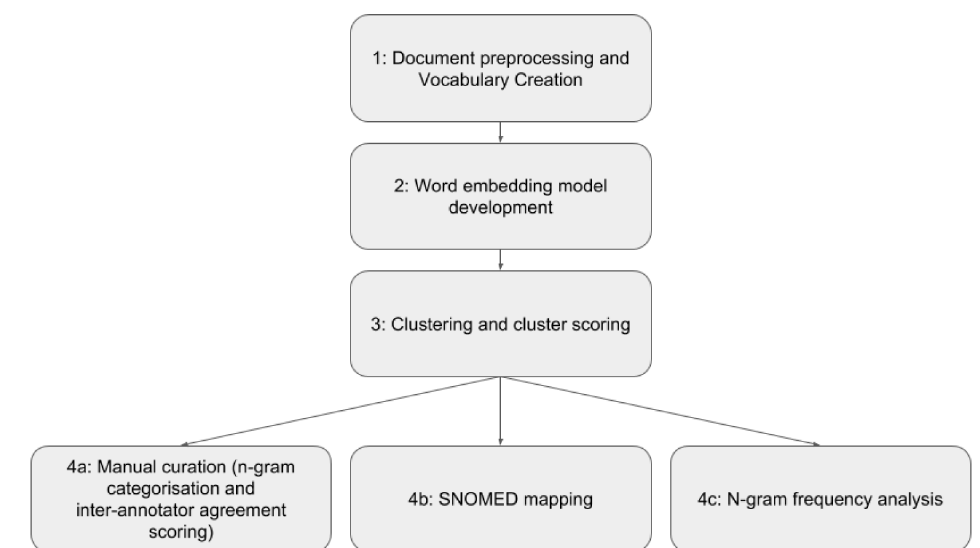
Figure 1. Overview of project